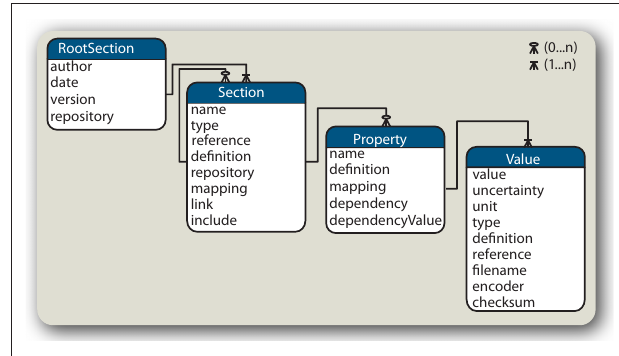
Figure 2 | Open metaData Markup Language entity-relation diagram. The od ML model is a tree structure of Sections and Properties . Connecting lines and “crow’s feet” indicate the relationship between the entities. For example: a Section can contain 0 to many (n) Properties which in turn must have at least 1 Value . The recursive connection of the Section indicates that there can be 0 to many subsections building the tree. All is embraced by a RootSection that contains some document-related elements. All elements listed in the different entities may at maximum